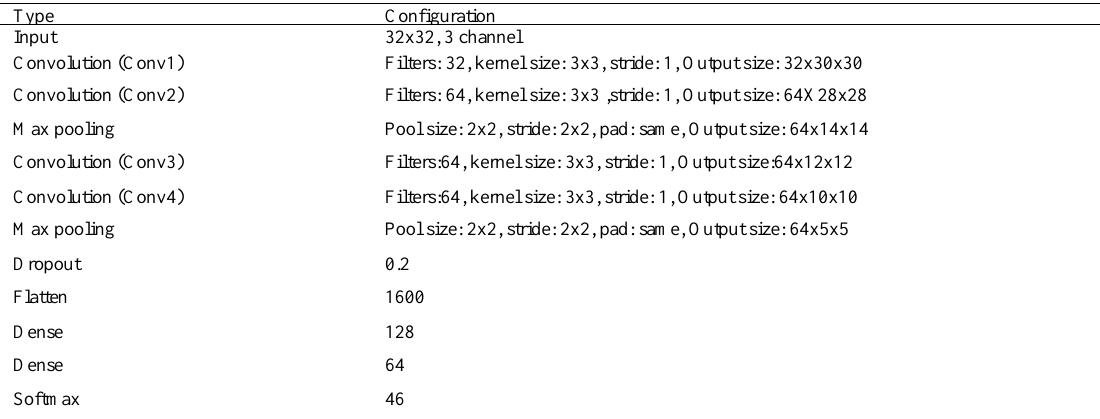
Table 3. Network configuration of CNN